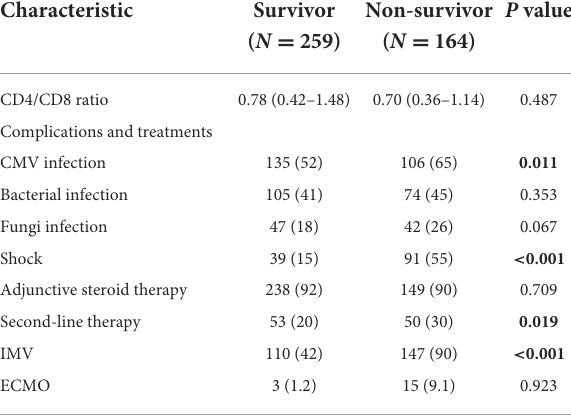
Figure 2A. The ideal C-index and AUC value showed good discrimination. The calibration curve is illustrated in Figure 2B, which demonstrates that the predictive consistency of death risk of the nomogram was consistent with the actual death risk of patients with